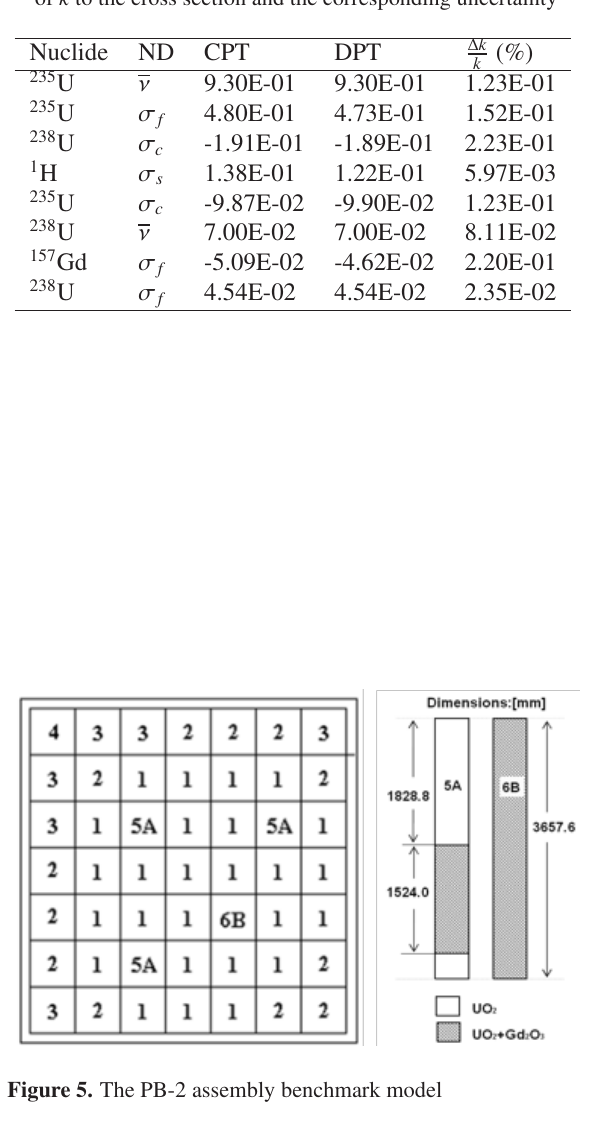
Table 2. The uncertainty of k caused by the 235 U and 238 U cross sections for the PB-2 assembly